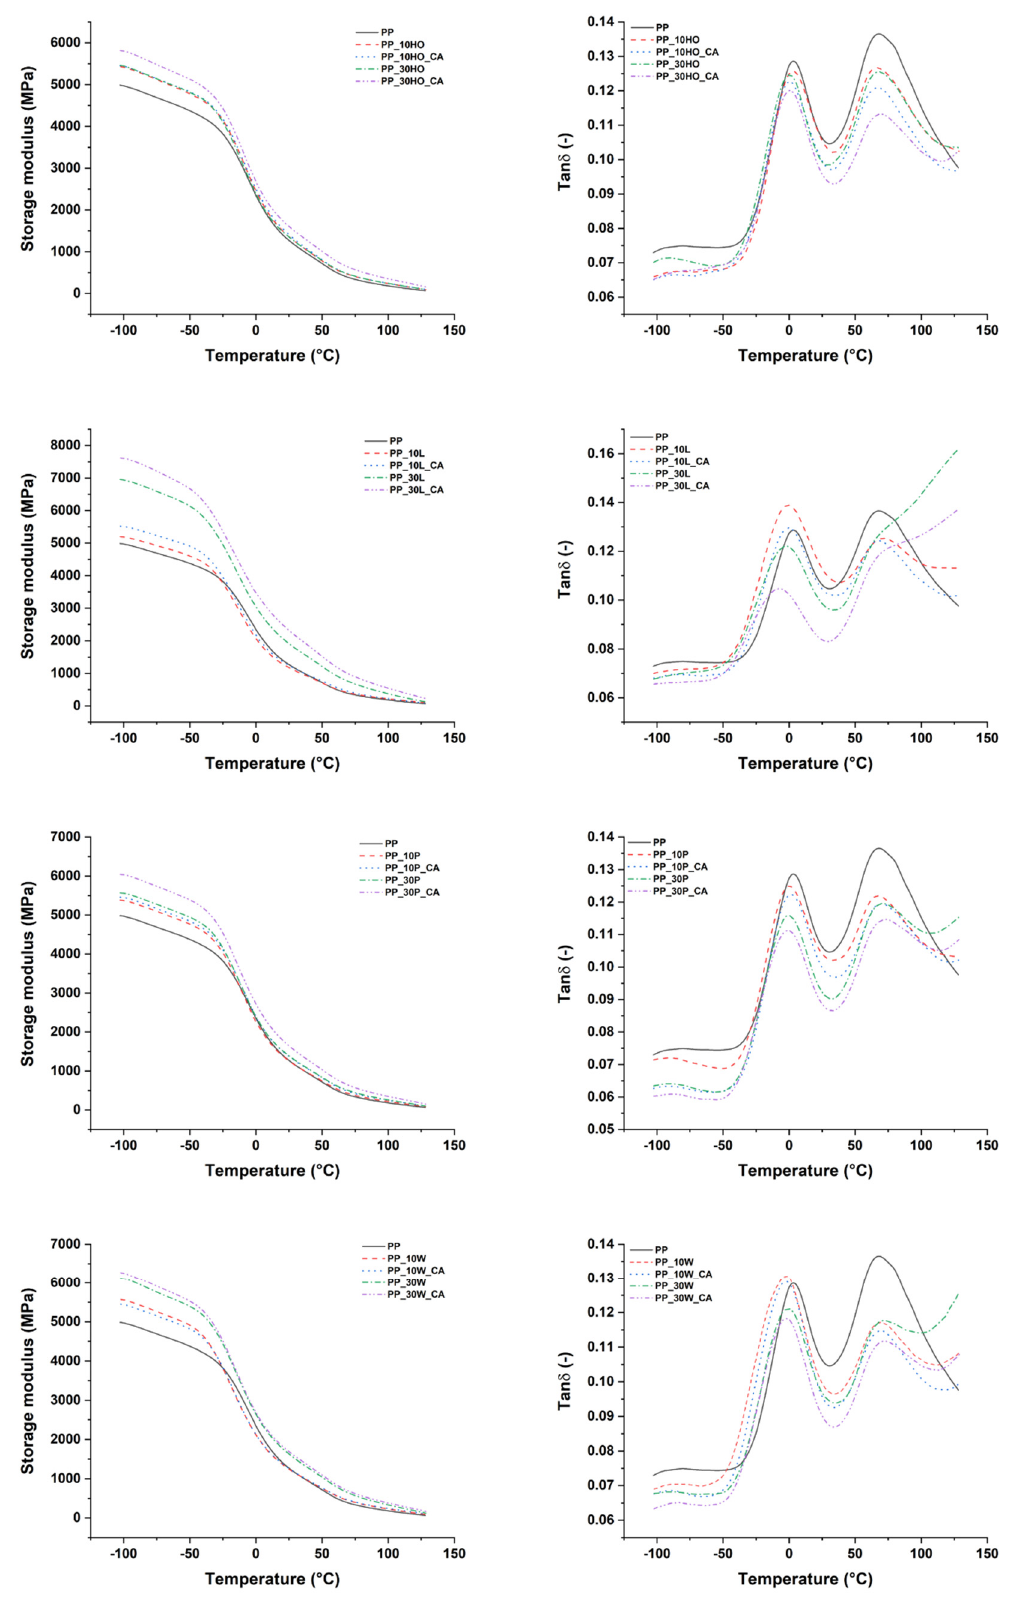
Figure 6. DMA thermograms of storage modulus ( left ) and tan δ ( right ) of PP-based composites.